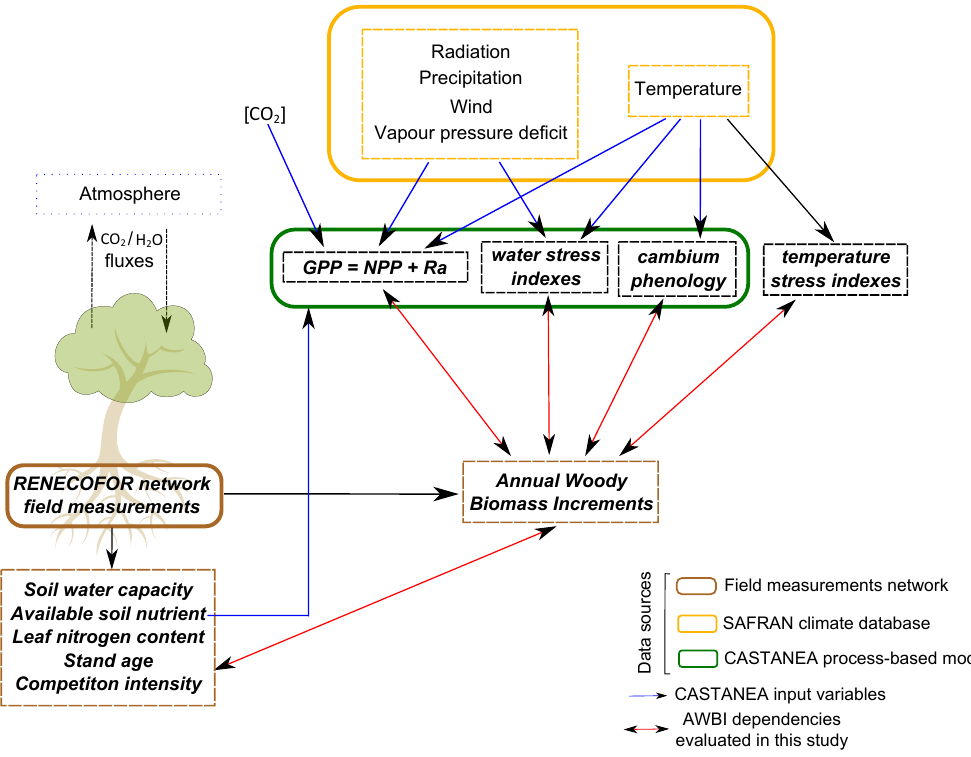
Figure 1. The conceptual framework and the three sources of data (field measurements, climate reanalysis and process-based simulations) used in the